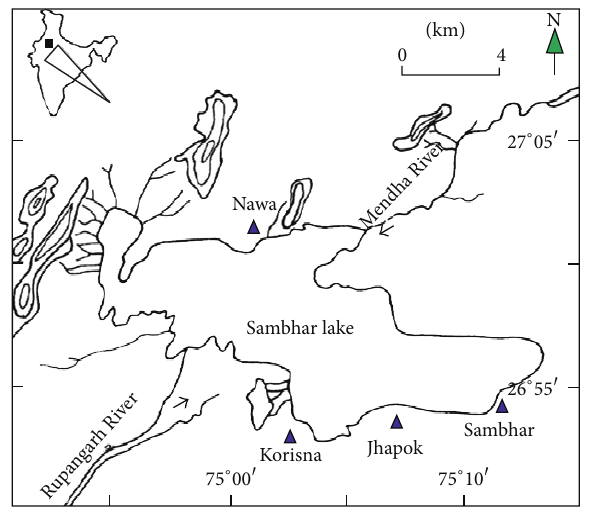
Figure 1: Schematic map of sampling site, Sambhar salt lake,